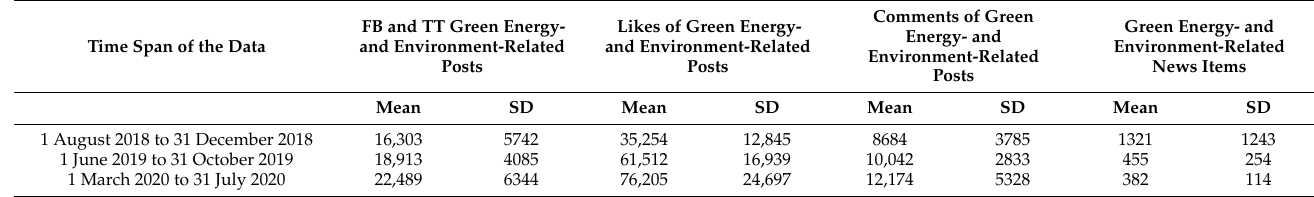
Table 1. Descriptive statistics of environment-related posts and news items.